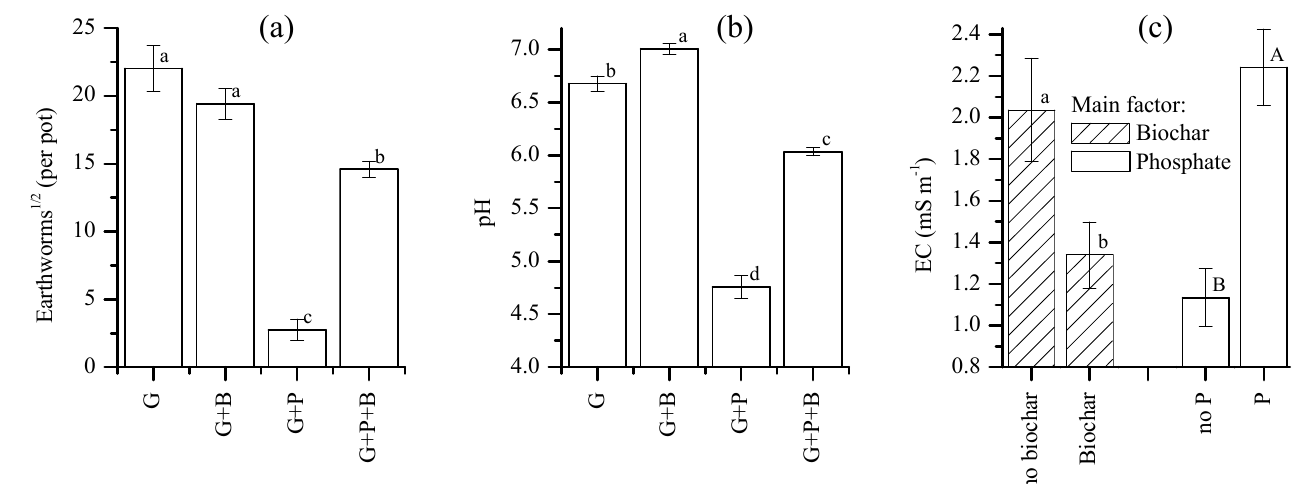
Figure 1. Square root of earthworm number after inoculation for 90 days in different composted substrates ( a ); pH ( b ) and electrical conductivity (EC) ( c ) of the vermicompost. G: grass clippings; G + B: grass + biochar; G + P: grass + phosphate; and G + B + P: grass + biochar + phosphate. Columns with the same lower-case letters (for earthworms, pH and biochar factor for EC) and upper-case letters (for P factor for EC) indicate no statistical difference at p < 0.05 using Duncan test. Vertical bars denote standard errors.